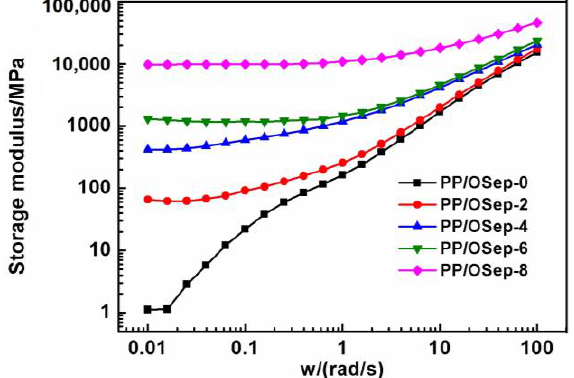
Polymers 2023 , 15 , x FOR PEER REVIEW 8 of 13 Figure 7. Storage modulus of PP/Osep nanocomposites with different Osep contents. Figure 7. Storage modulus of PP/Osep nanocomposites with different Osep contents. Figure 7. Storage modulus of PP/Osep nanocomposites with different Osep contents.